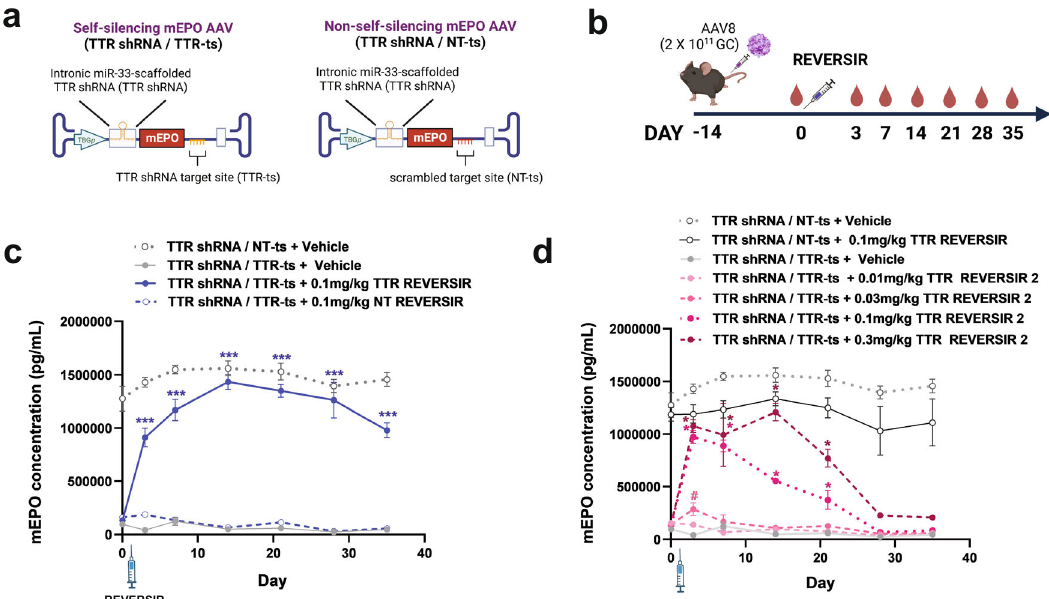
Fig.2|REVERSIR-mediatedregulationofanerythropoietintransgene.a Vector genome schematics for AAV encoding mouse EPO (mEPO) transgene under con- trol of TTR shRNA with intact (self-silencing; TTR shRNA/TTR-ts) or scrambled (non-self-silencing; TTR shRNA/NT-ts) binding site in 3 ’ UTR. b Mice were trans- duced with 2×10 11 GC of AAV8 vectors shown in ( a ) for two weeks and then subcutaneously injected with REVERSIR. Serum was collectedfor quanti fi cation of mEPO levels by ELISA at indicated days prior to and following REVERSIR admin- istration . c Serum EPO concentrations in mice that received 0.1mg/kg 9-mer TTR orNTREVERSIR,comparedtovehiclecontrolonD0( n =4miceforvehiclegroups and n =3 mice for REVERSIR groups). Data were analyzed by two-way repeated measures ANOVA with Tukey ’ s post hoc test ( *** p <0.001 relative to TTR shRNA/ TTR-ts + NT REVERSIR control). d EPO concentrations following treatment with increasing dosesofTTR REVERSIR2(0.01, 0.03, 0.1,or 0.3mg/kg).Experiments in